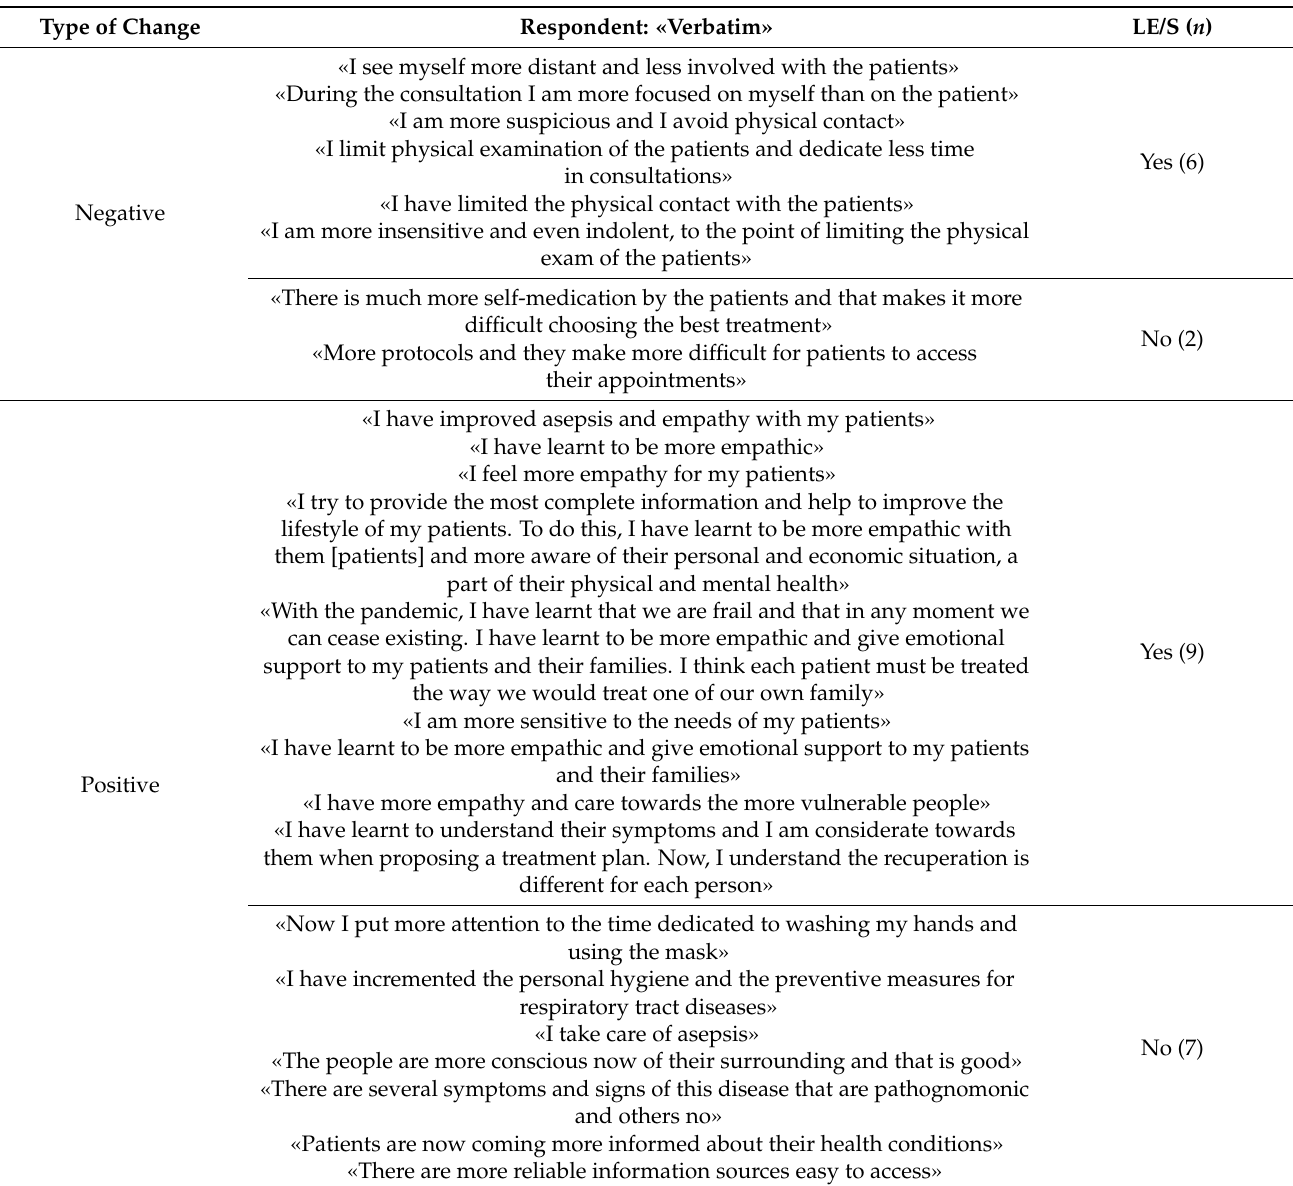
Table 4. Verbatim of changes self-perceived by physicians in their relationships with the